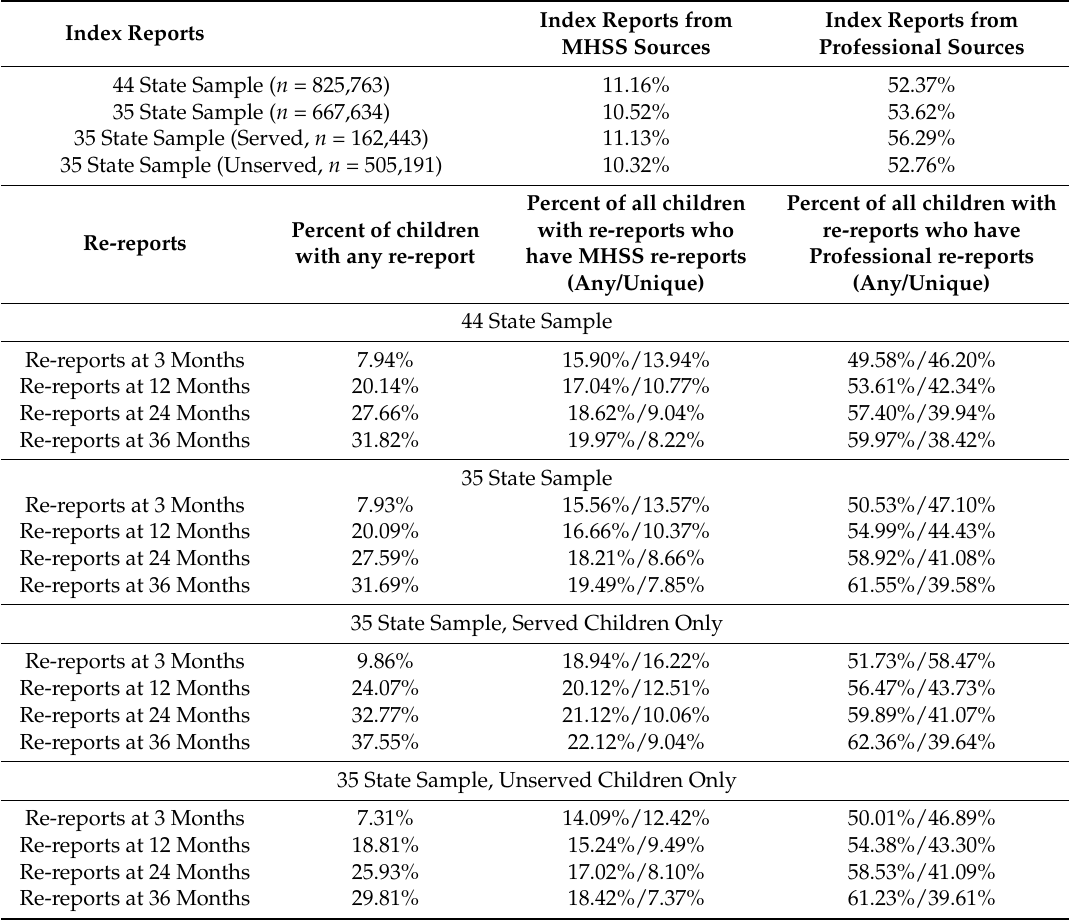
Table 1. Types of index reporter and re-reporters over time (National